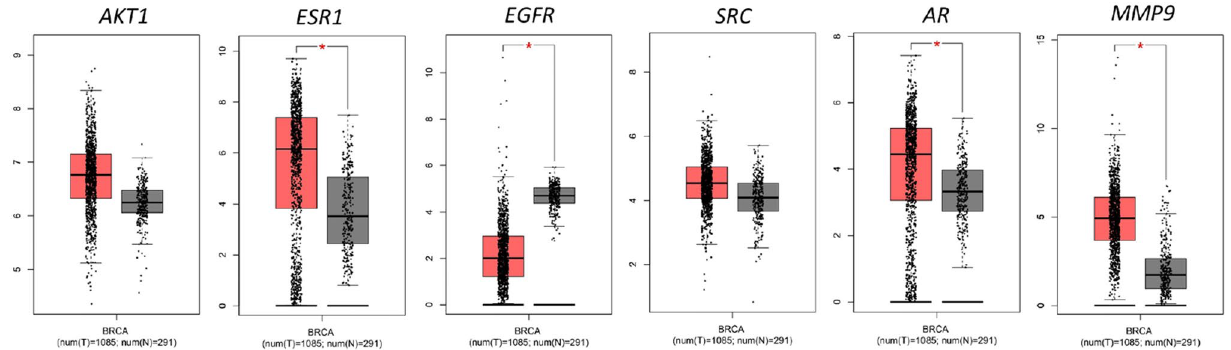
Fig. 7 Boxplots showing the expressions of genes AKT1, ESR1, EGFR, SRC, AR and MMP9 in breast cancer patients (shown in red) versus normal controls (shown in grey) in the patient dataset BRCA